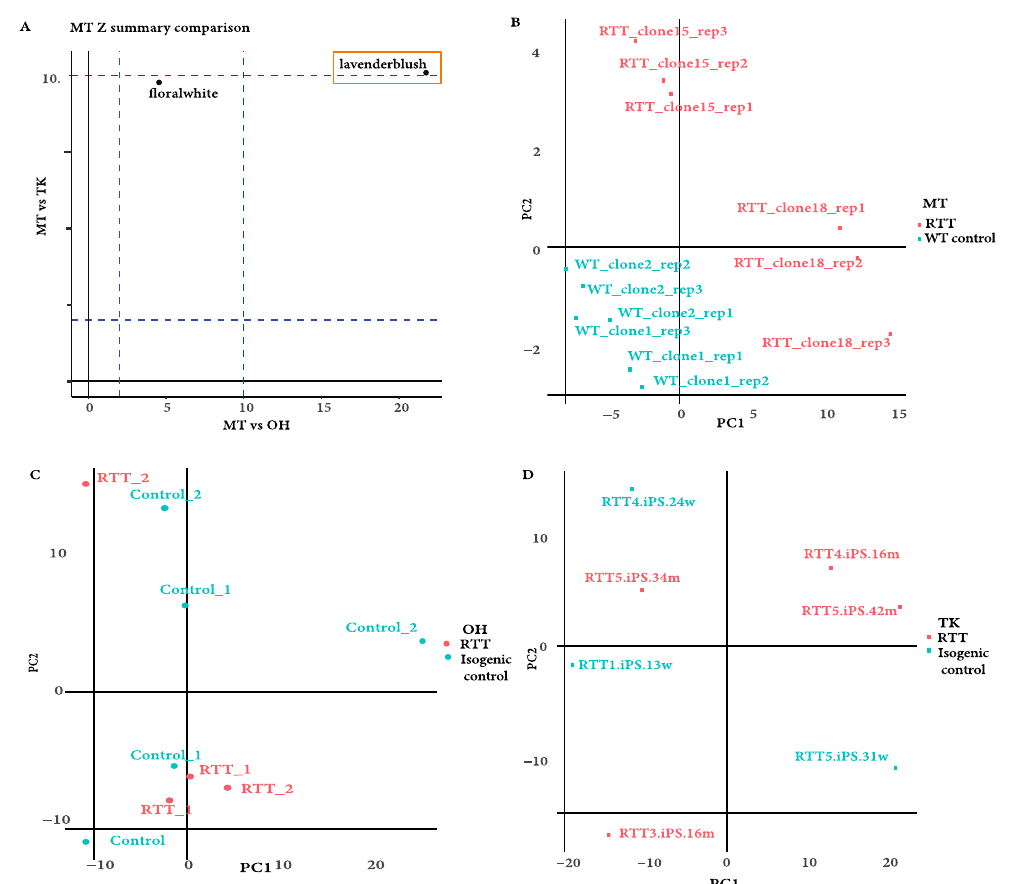
Figure 5. ( A ). Preservation analysis performed based on GSE21037 (MT) against GSE107399 (OH) and GSE51607 (TK). Lavenderblush represents the highest preservation score. ( B – D ). PCA plots for each dataset showing gene expression profiles of the lavenderblush module obtained through WGCNA, and clustering of samples according to their gene ex- pression.